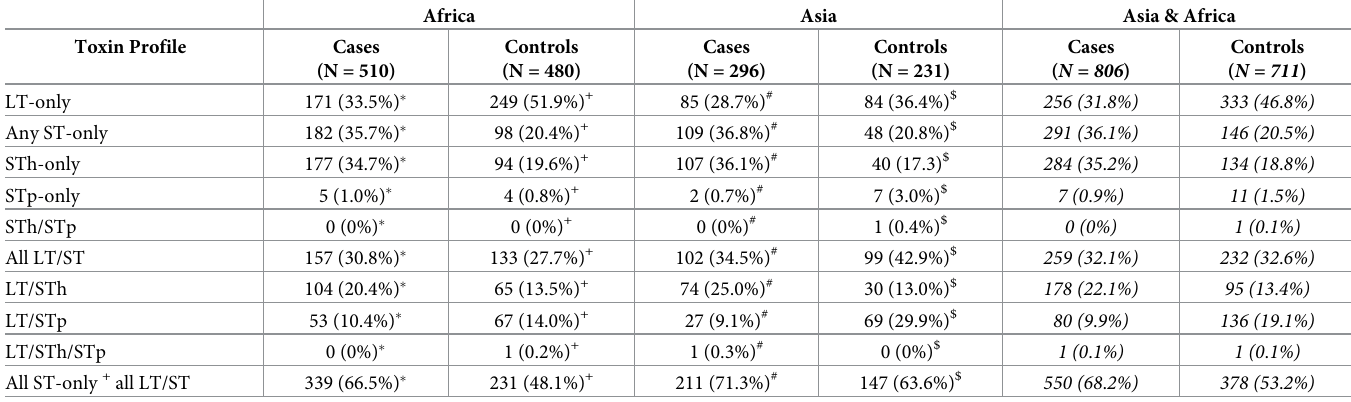
Table 2. Toxin profile of ETEC isolates from cases and from controls by continent and across all seven GEMS sites combined. Africa Asia Asia & Africa Toxin